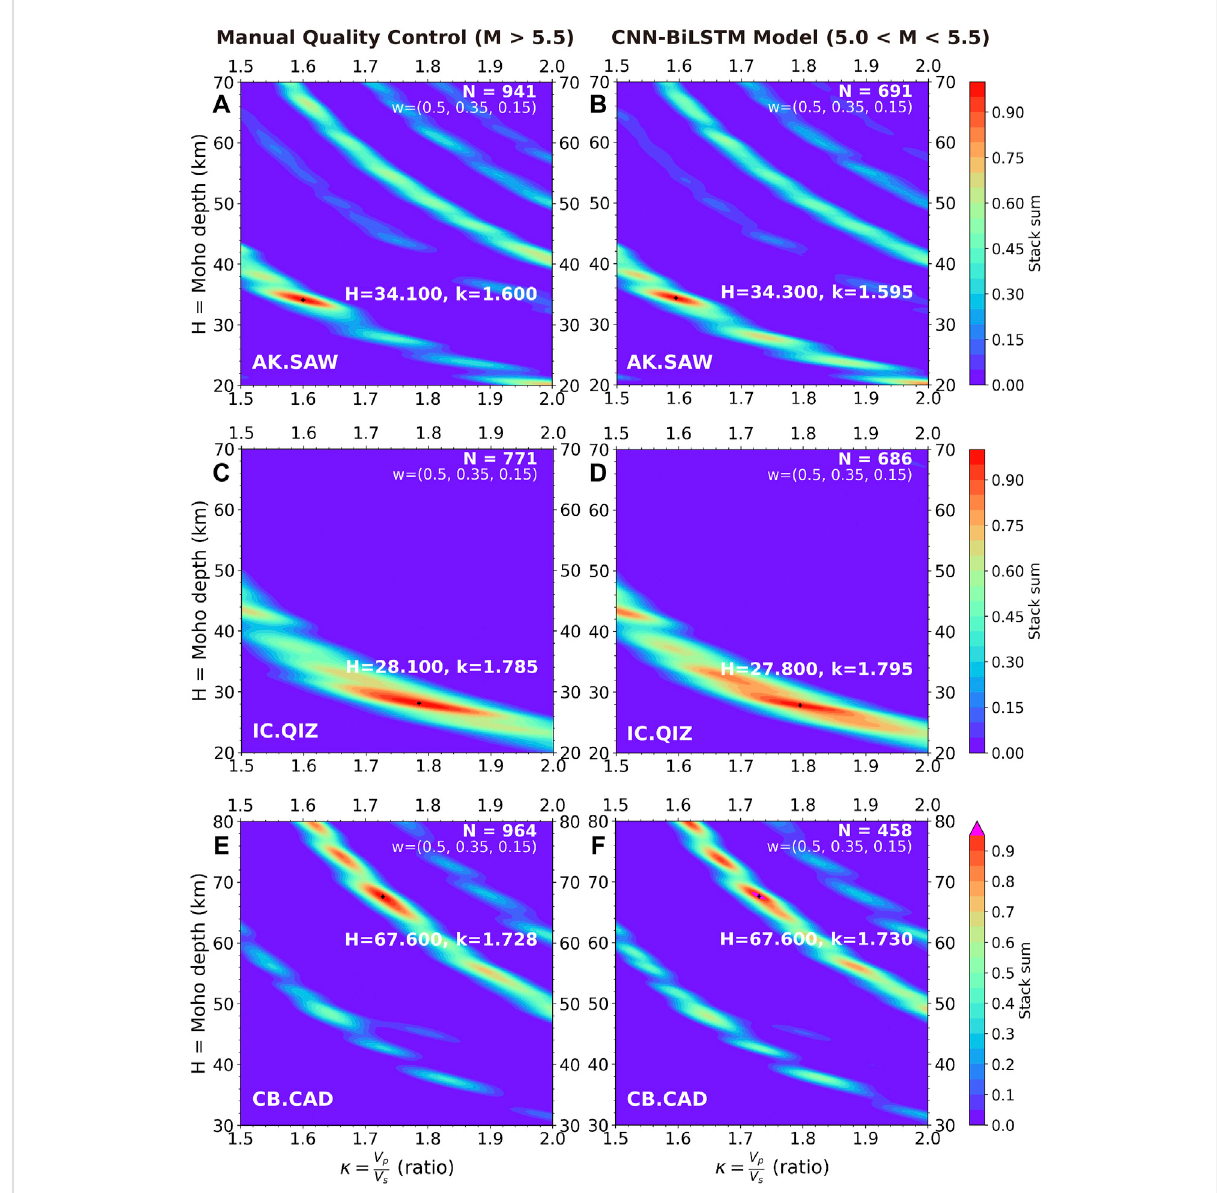
FIGURE 6 Thickness (H) versus Vp/Vs ratio ( κ ) diagrams from the H- κ stacking method for representative datasets. (A) Manually quality controlled station AK.SAWdatasetwithearthquakemagnitudes largerthan5.5. (B) AutomaticallyqualitycontrolledstationAK.SAWdatasetbytheCNN-BiLSTMmodel withearthquakemagnitudesbetween5.0and5.5. (C,D) arethesameas (A,B) butforstationIC.QIZdatasets. (E,F) arethesameas (A,B) butforstation CB. CAD